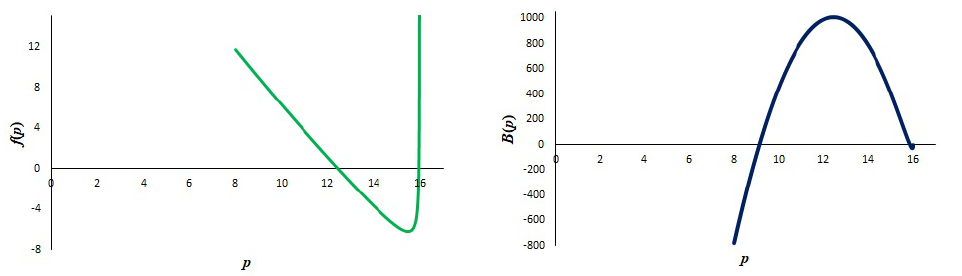
Figure 4. Functions f ( p ) and B ( p ) for Example 1.